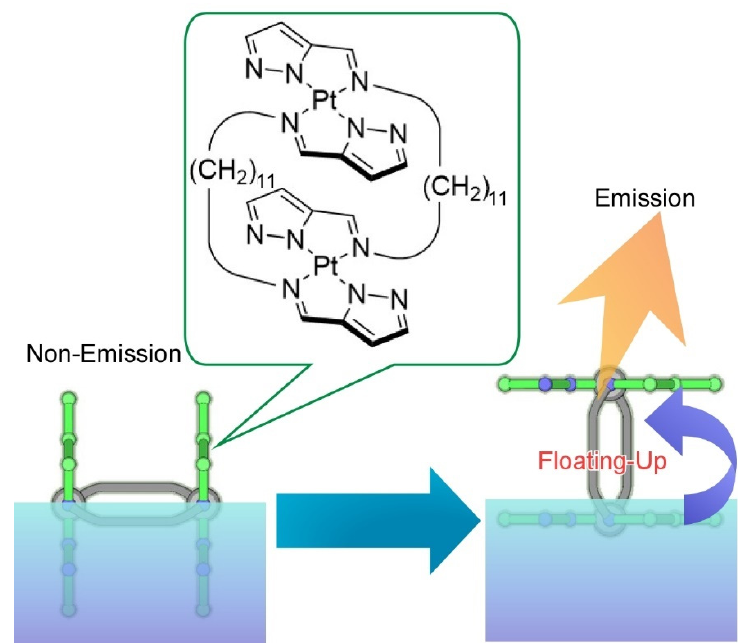
Figure 15. Faint orientational changes of double-paddled binuclear Pt II at the air-water interface from perpendicular to parallel accompanied with drastic increase of phosphorescence, as called submarine emission.